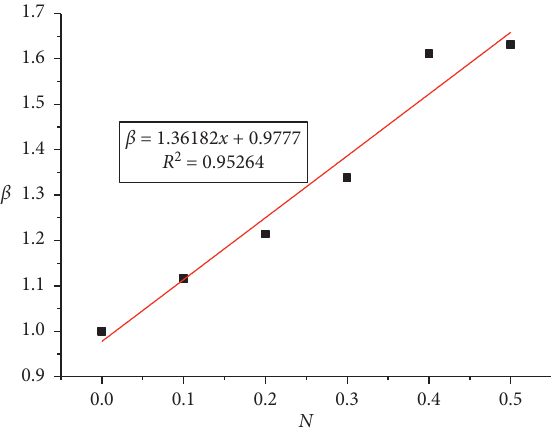
Figure 5: Calculation of the offset